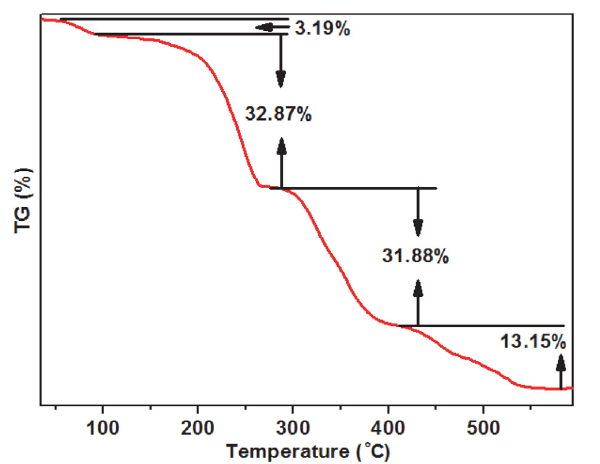
Figure 7. A TG diagram of 1